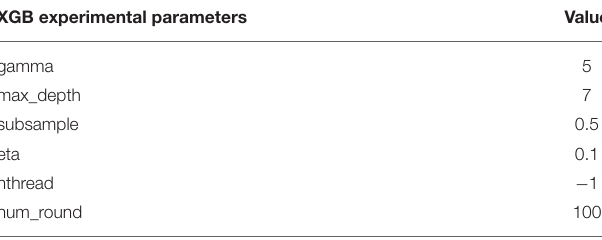
TABLE 3 | XG-boost parameter